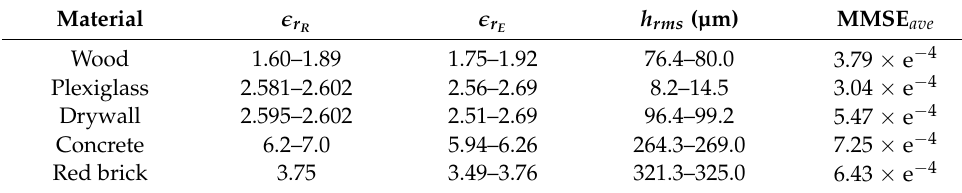
Table 7. Collection of Estimated Parameters and